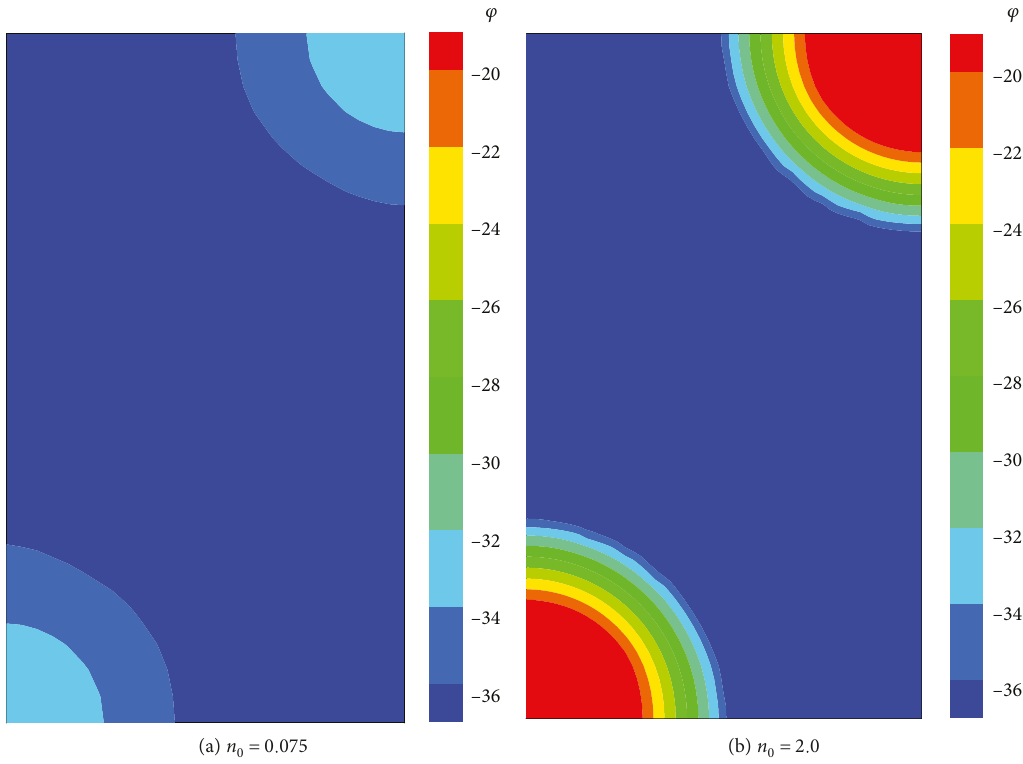
Figure 11: Potential distribution of the downstream surface of the accelerator grid of the 2-grid optics.